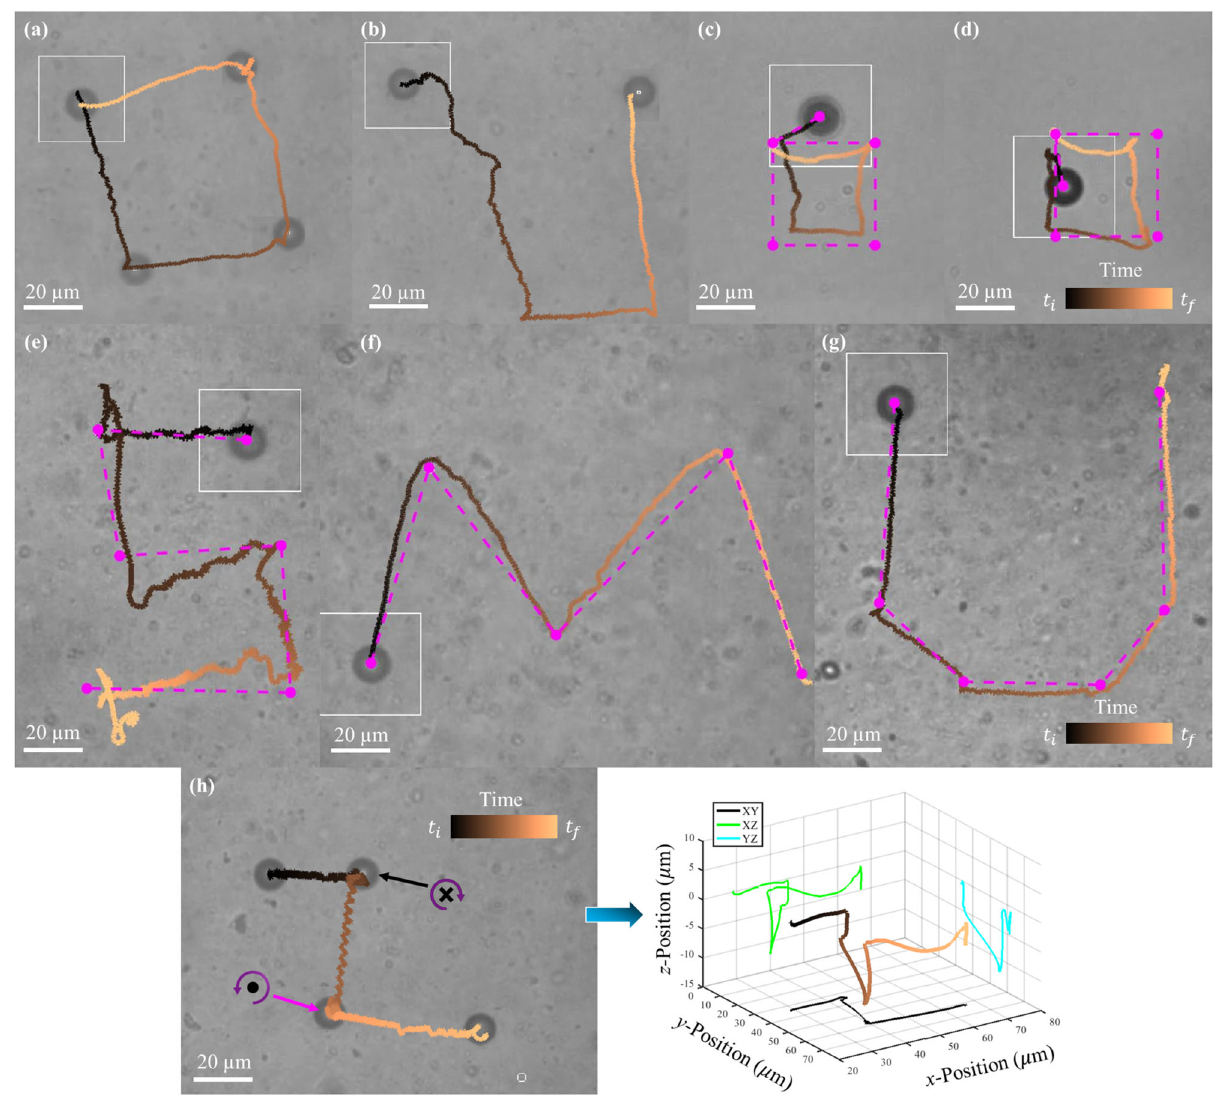
Fig. 2 Path planning of microparticles in nonlinearly viscoelastic fl uids. a Open-loop control of a microparticle performing a square trajectory in 4% mucin. b Open-loop control of a microparticle in 4% mucin, which encounters a region of relatively high fl uid resistance, disrupting its initial downward motion. Selected trajectories of a microparticle under closed-loop feedback control in 0.25% polyacrylamide ( c , d ) and 4% mucin ( e – g ), where magenta dots represent the intended targets and dashed lines represent shortest path. The times associated with each trajectory are ( a ) 80 s, ( b ) 95 s, ( c ) 156 s, ( d ) 145 s, ( e ) 94 s, ( f ) 60 s, and ( g ) 43 s. h Left: a simple 3D trajectory that was achieved using open-loop control. At the points indicated by the arrows, the microparticle translated downwards in the negative z- direction (black arrow) and then upwards in the positive z- direction (magenta arrow); the circular purple arrow signi fi es rotation direction from behind the heading vector, while the black circle and × represent out of the page and into the page, respectively. Right: the estimated 3D trajectory of the microparticles path and projections along the different planes; the total time of the trajectory was 114 s. Microparticles were rotated at ( a – c, e – g ) 19 Hz, ( d ) 40 Hz, and ( h ) 15 Hz. Source data are provided as a source data fi le. These experiments were repeatable for >90% of all particles examined in 4% mucin and >60% of all particles examined in 0.25%